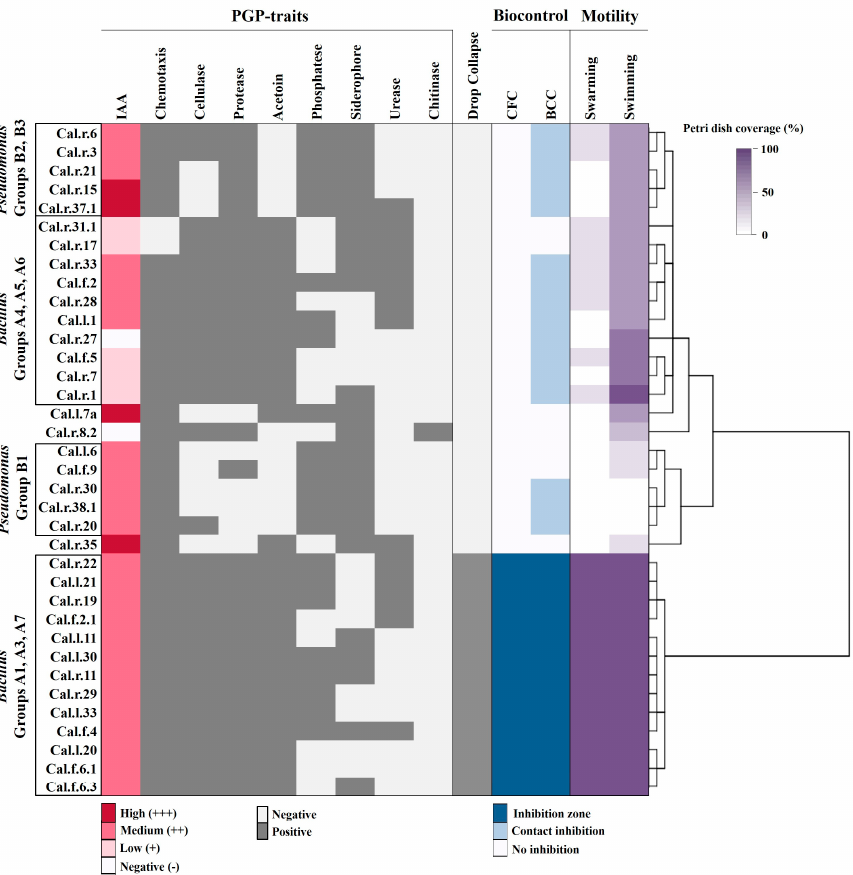
Figure 3. Hierarchically clustered heatmap of plant growth promoting (PGP) traits (light grey, positive; dark grey, negative), IAA production (white: negative, light pink: low production, pink: medium production, dark pink: high production), motility on different surfaces (% Petri dish coverage) and biocontrol capacity (white: no inhibition, light blue: contact inhibition, dark blue: inhibition zone) of BCC (Bacterial Cell Culture) and CFC (Cell-Free Culture). The hierarchical clustering was created to group the bacterial strains by similar reaction to the different assays tested.